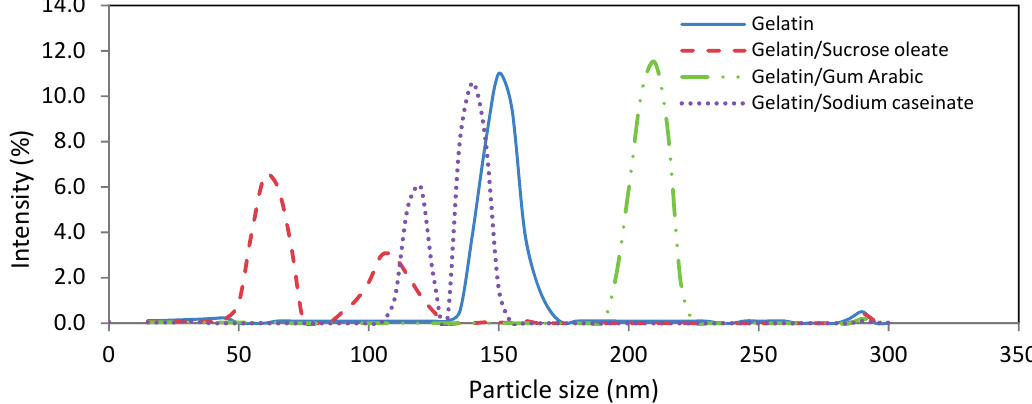
Figure 3. Particle size distribution of freshly prepared astaxanthin nanodispersions stabilized using different gelatin-based emulsifying